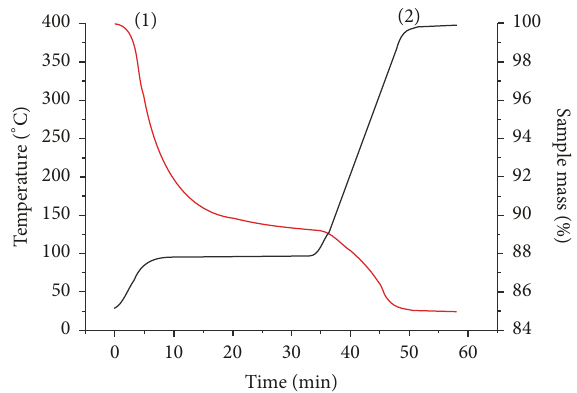
Figure 12: TGA of V 2 O 5 ⋅ 1.8H 2 O: (1) sample mass; (2)